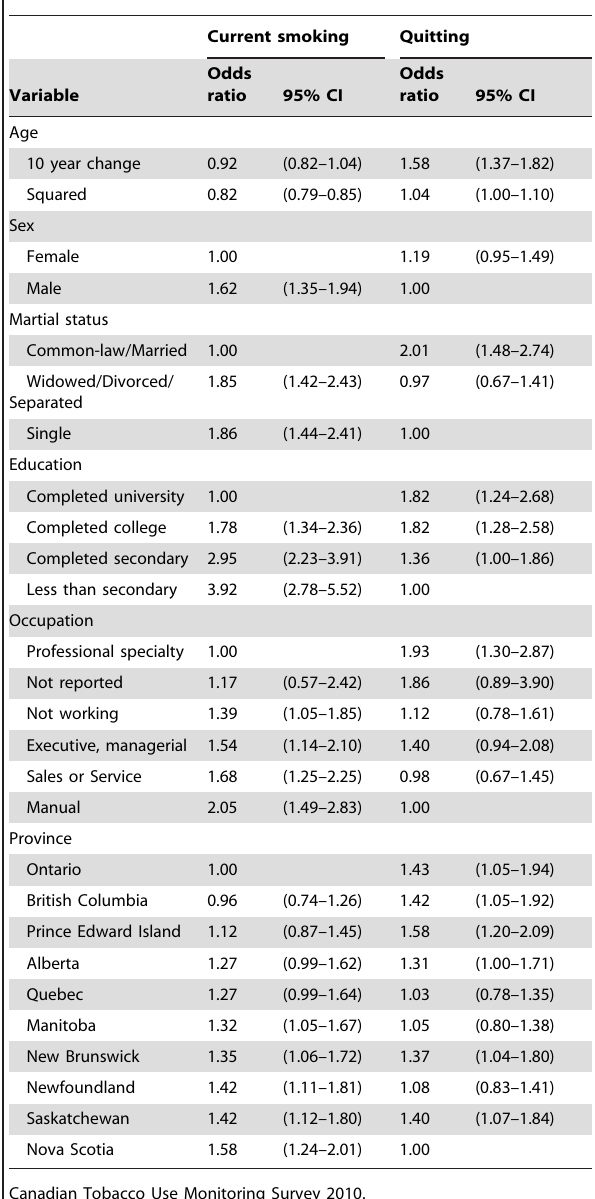
Table 2. Mutually adjusted odds ratios and 95% confidence intervals from logistic regressions of current smoking and quitting on demographic and socioeconomic characteristics and province of